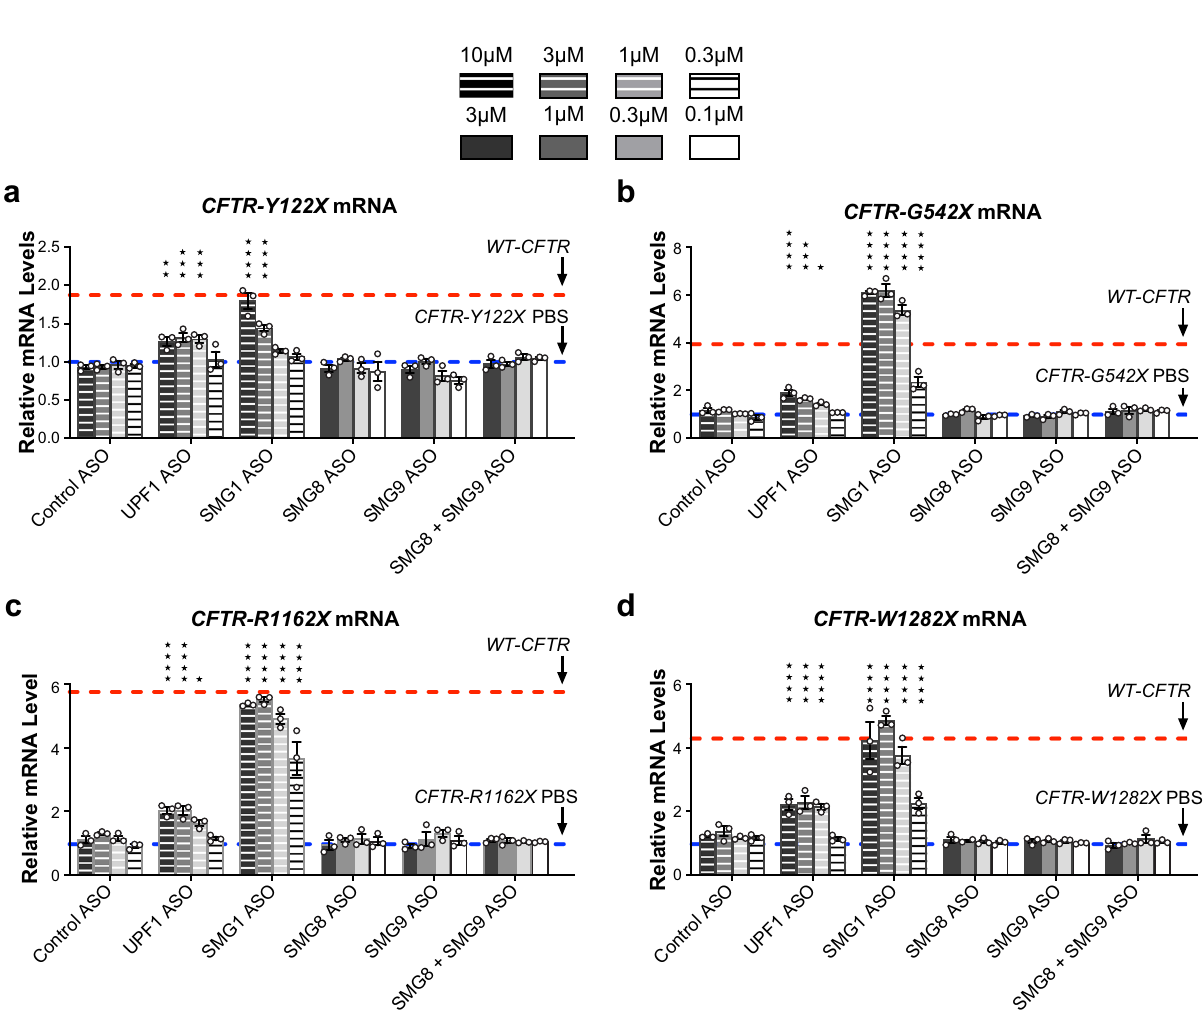
Fig. 3 CFTR mRNAs containing nonsense codons are regulated by UPF1 and SMG1 but not SMG8 or SMG9. RT-qPCR analysis of CFTR mRNAs in CFF- 16HBEge cells with ( a ) Y122X, ( b ) G542X, ( c ) R1162X, or ( d ) W1282X CFTR nonsense mutations treated with ASOs targeting UPF1 , SMG1 , SMG8 , or SMG9 . Cells treated with PBS or a scrambled control ASO were used as negative controls. CFTR mRNA levels were normalized to total RNA levels. CFTR mRNA levels were also normalized to housekeeping gene β -actin mRNA (Supplementary Fig. 5). PBS control levels were set to 1 and are indicated by dotted blue lines. Wild-type (WT) CFTR mRNA levels in parental cells are indicated by dotted red lines. n = 3 in each group. Data are presented as mean ± SEM from biologically independent samples. Statistical signi fi cance was analyzed by two-way ANOVA followed by Dunnett ’ s multiple-comparison test (* p < 0.05, ** p < 0.01, *** p < 0.001, **** p < 0.0001). See Source Data fi le for the exact p -values. Source data are provided as a Source Data fi